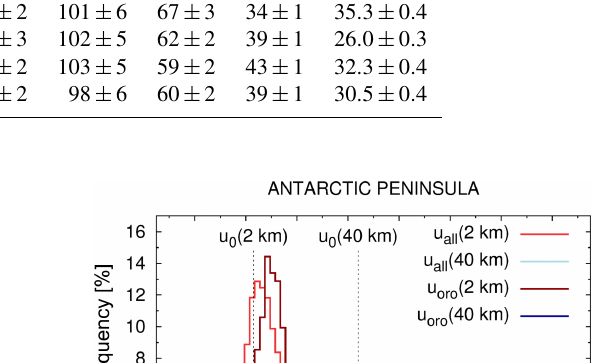
Table 2. Zonal wind thresholds and skill scores of the mountain wave prediction model. The table provides the probability of detection (POD), the false alarm rate (FAR), and the Gilbert skill score (GSS). Hotspot u 0 (40km) u 0 (2km) bias POD FAR GSS (ms − 1 ) (ms − 1 ) (%) Andes 50 ± 3 6 ± 2 98 ± 5 Antarctic Peninsula 44 ± 3 3 ± 2 Tasmania